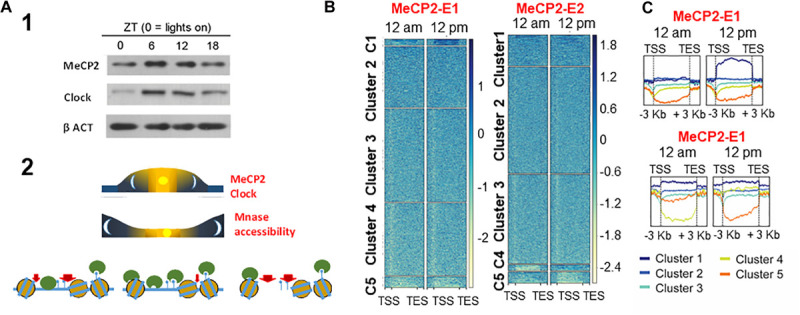
Circadian-dependent MeCP2 (A-1) and resulting chromatin changes (A-2) and diurnal dynamic change heatmaps for MeCP2-E1 and MecP2-E2 isoform gene occupancy (B), divided into 5 clusters, with isoform-specific enrichment on the different clustered genes over time shown in (C). MeCP2-E1 and MeCP2 enrichment differences in the different clusters in (A) (Martinez de Paz et al., 2015; Martínez de Paz et al., 2019).